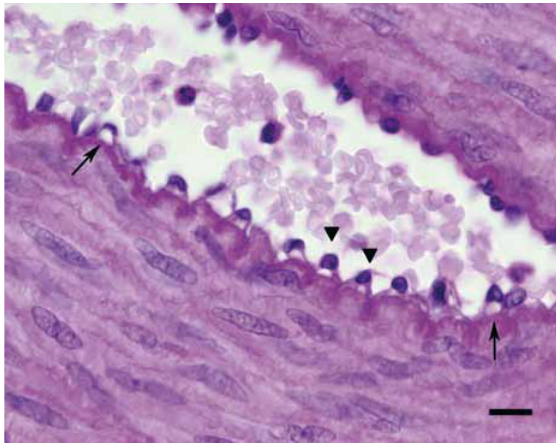
Figure 1 - Tunica intima of the DAP of a control rabbit. Sections were stained with PAS stain, and images were taken at 1000x magnification. Scale bar: 10µm.